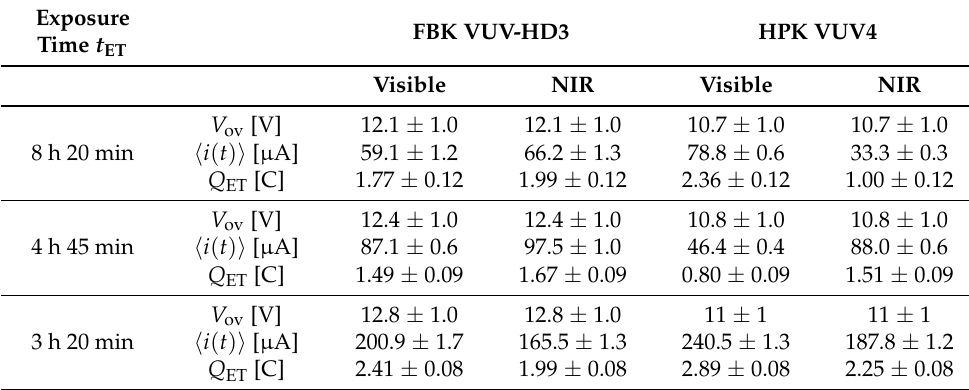
Table 3. Summary of the exposure time ( t ET ), over-voltage V ov , total charge Q ET (as defined by Equation (2)) and average current (cid:104) i ( t ) (cid:105) during SiPM spectral